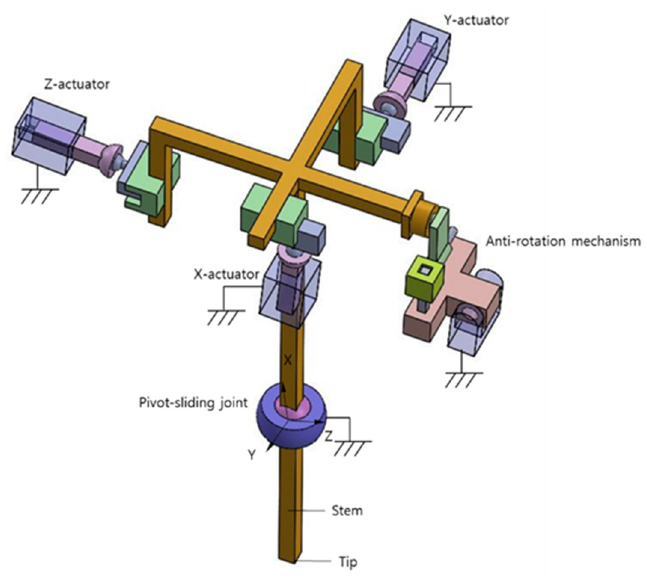
Figure 2. A spatial parallel manipulator driven by three linear actuators arranged perpendicularly.